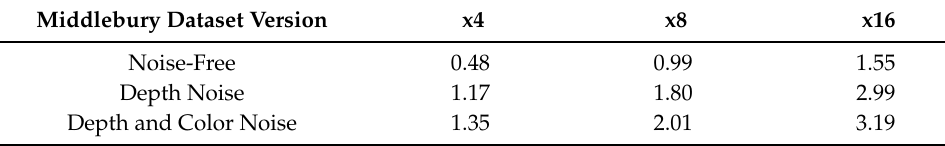
Table 3. An Analysis of the average RMSE values for different noise schemes.